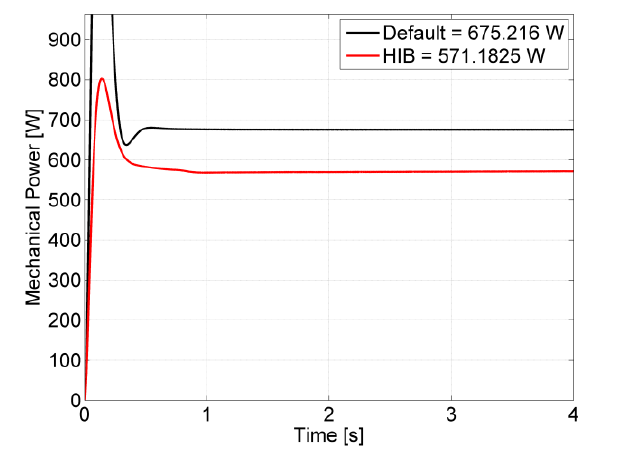
Fig. 15. SRG mechanical power after hybrid GA optimization.